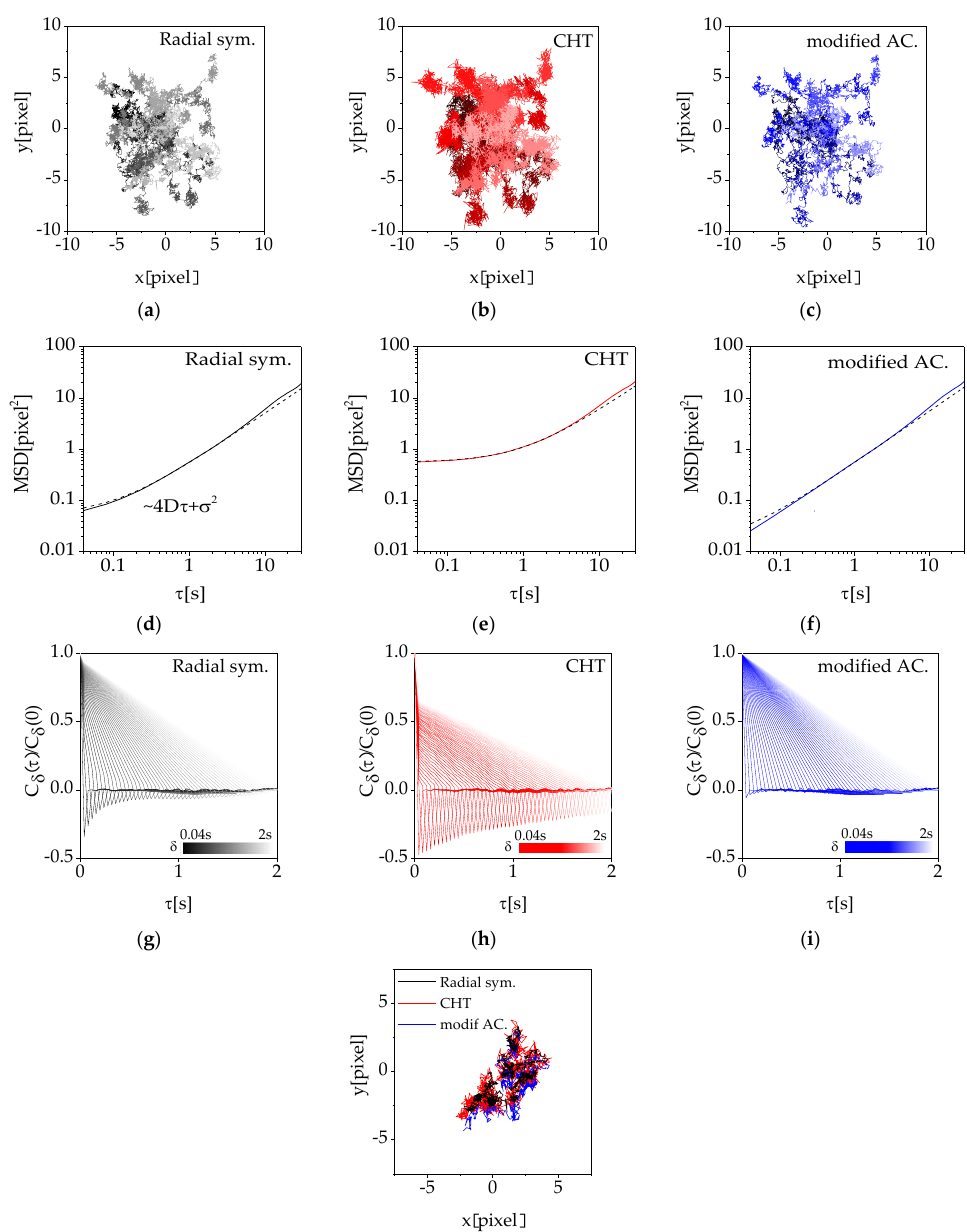
Figure 4. Random dynamics of MCF-7 cells analyzed by the tracking methods. The ( a – c ) trajectories, ( d – f ) MSDs, and ( g – i ) VACFs δ from 0.04 to 2 s calculated by the radial symmetry, circular Hough transform, and modified active contour methods (N = 36). ( j ) The comparison of the representative trajectory achieved from 3 different localization methods.